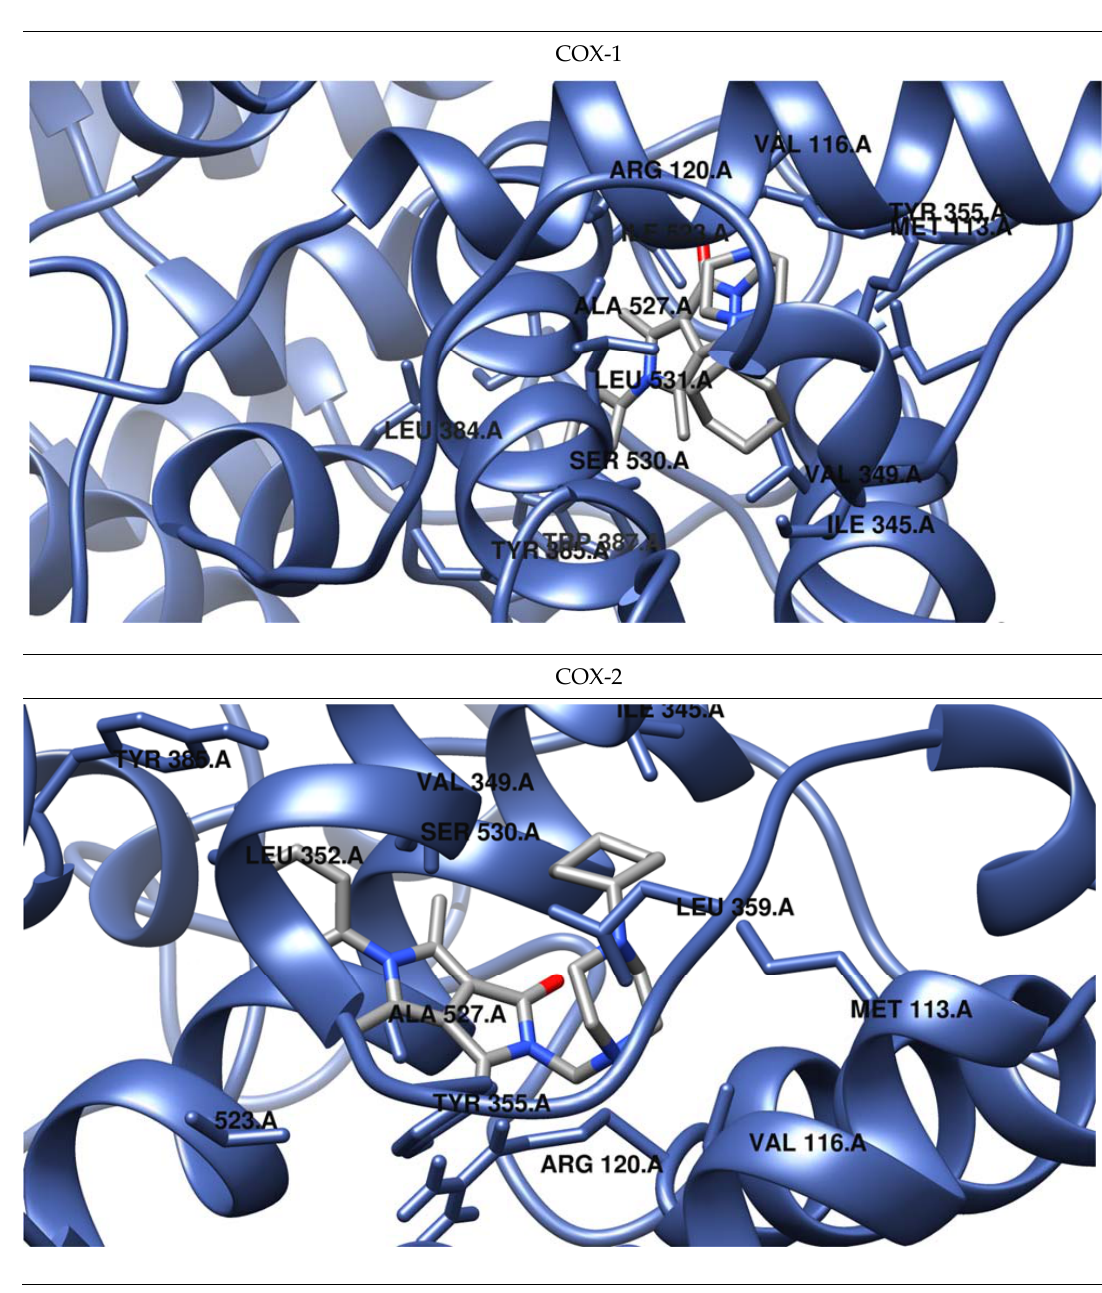
Figure 5. Predicted orientations of the lowest energy conformations of 2h towards COX-1 and COX-2. The docked ligand was zoomed graphically for each